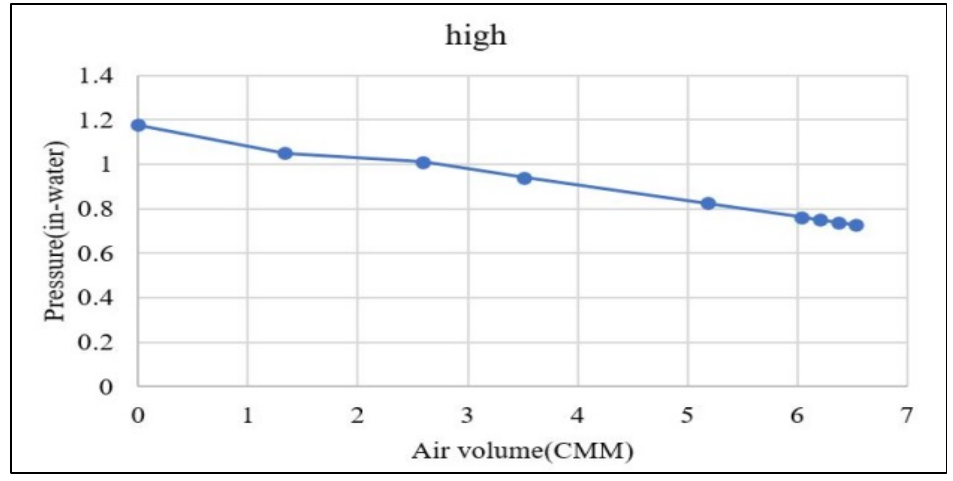
Figure 11. P-Q curve of the air purifier at a high rotation speed.